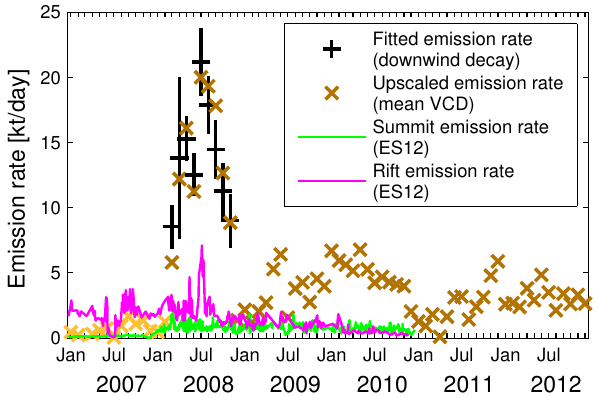
Figure 7. Time series of Kılauea’s SO 2 emission rate. Black: results from the monthly fits (as in Fig. 5). Orange: emission rate estimates based on the monthly mean SO 2 VCD, using the linear relation de- rived in Fig. 6. Values prior to the opening of the Kılauea sum- mit vent in March 2008 are marked in light orange, as the up- scaled emission rates are very likely biased low (see text). Green and magenta: emission rate estimates by Elias and Sutton (2012) (labeled as ES12), derived from ground-based measurements, for the Kılauea summit and East Rift,